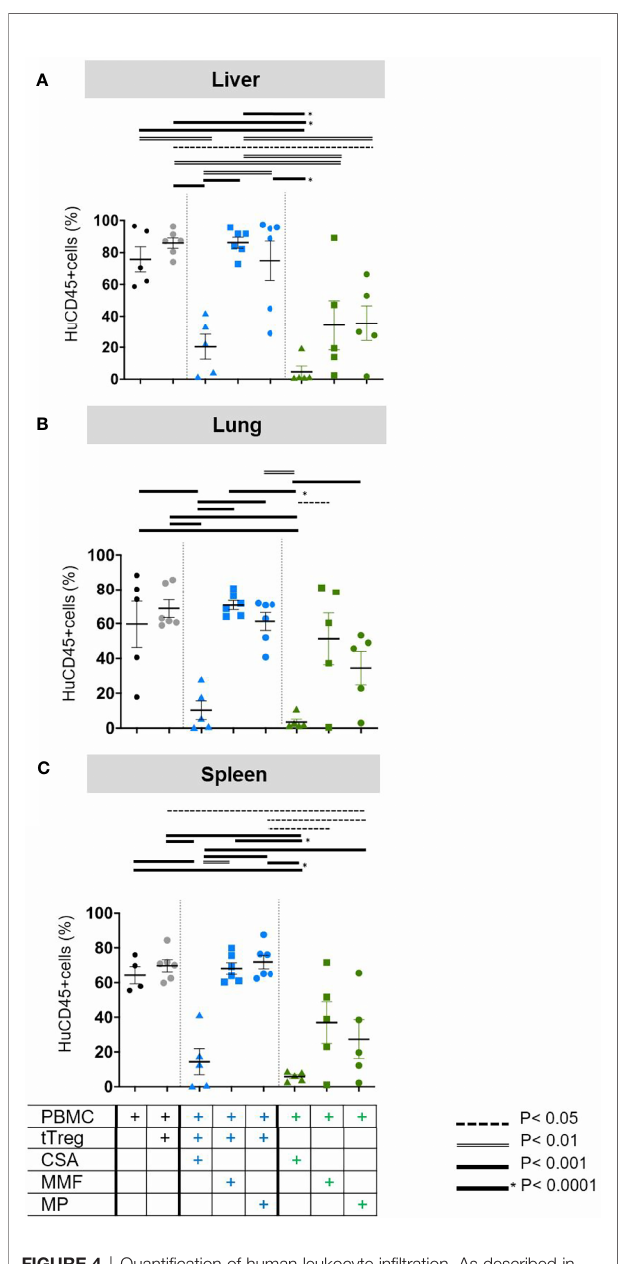
FIGURE 4 | Quanti fi cation of human leukocyte in fi ltration. As described in Figure 1 GvHD was induced by 3x10 6 human PBMCs in NOD/SCID/ IL2Rgamma -/- mice. Mice were subsequently treated with (i) the individual cISD (green symbols), CSA (4 mg/kg s.c., green triangles), MMF (0.5 mg p.o., green squares) or MP (20 mg/kg i.p., green dots) (n=5) alone (n=5), (ii) with ex vivo expanded tTregs at a PBMC:tTreg ratio of 2:1 (n=6, grey dots), or (iii) with a combination of cISD and low dose tTregs (PBMC:tTreg ratio 2:1; CSA/ tTreg n=5, blue triangles; MMF/tTreg, blue squares; MP/tTreg n=6, blue dots). Postmortem liver (A) , lung (B) and spleen (C) were analyzed by fl ow cytometry to quantify the amount of in fi ltrating CD45+ cells. Depicted are individual values and means ± SEM. Statistical analysis was performed as One-Way-ANOVA with Tukey correction for multiple comparison. Statistical signi fi cance levels are indicated as p < 0.05 (dotted line), p < 0.01 (dashed line), p < 0.001 (bold line), p < 0.0001 (solid line with asterix). CSA, Cyclosporine A; MMF, Mycophenolate Mofetil; MP,